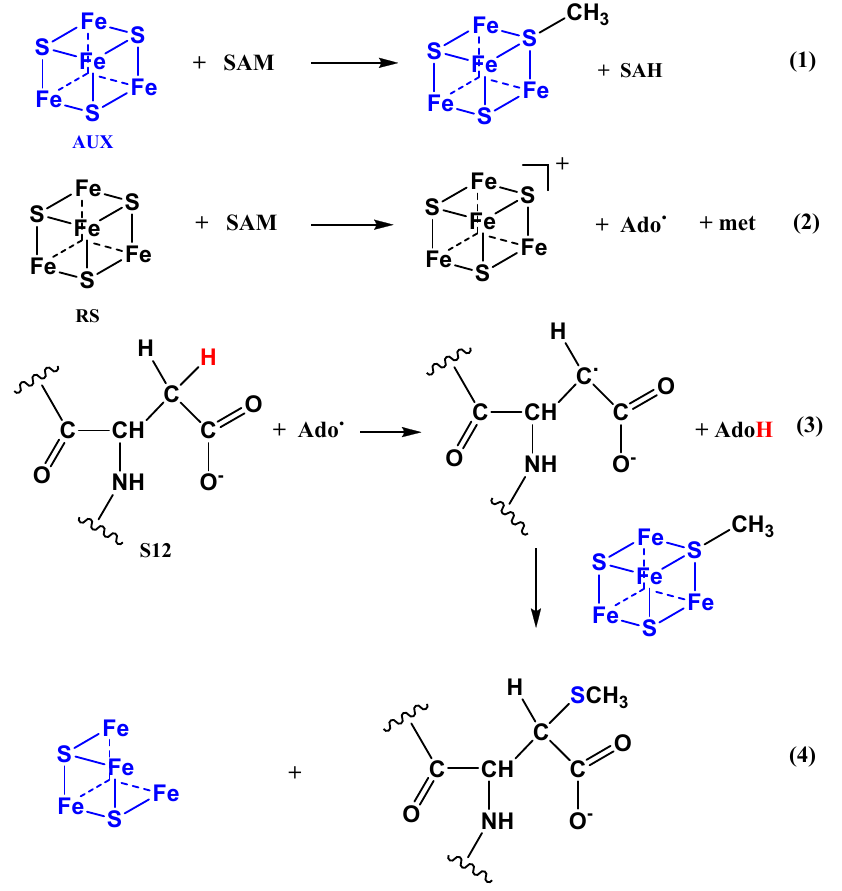
Figure 1. Mechanism of the thiomethylation of the ribosomal S12 protein by the RimO enzyme.